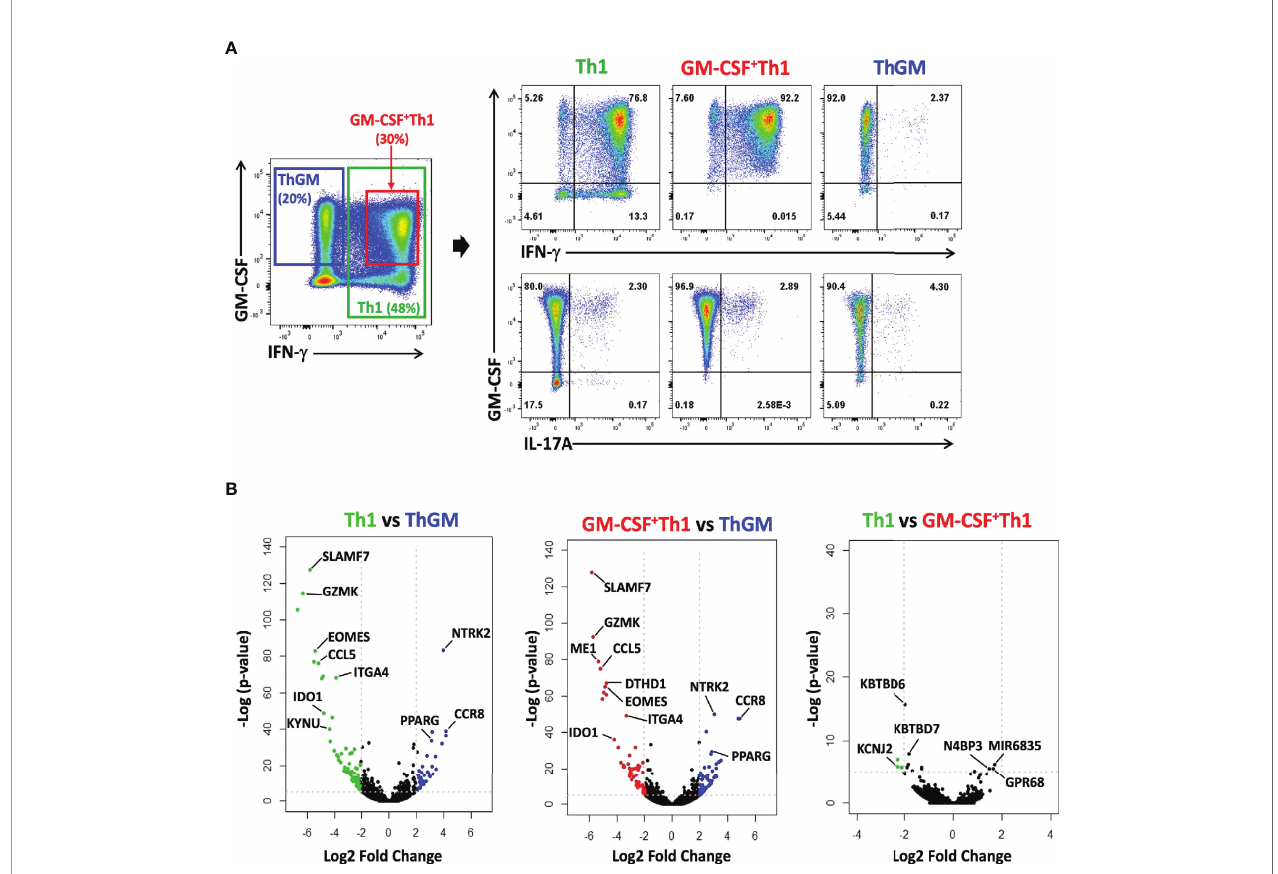
FIGURE 4 | ThGM cells have a unique transcriptome pro fi le. Human ThGM, Th1, and GM-CSF + Th1 cells were isolated from PB T M cells using a combination of FACS sorting and cytokine capture assay (n=6 subjects). RNA was extracted and analyzed using RNA-seq analysis. (A) Representative fl ow cytometry dot plots showing GM- CSF, IFN- g , IL-17A expression by total T M cells before separation, and of isolated Th1, GM-CSF + Th1, and ThGM cells isolated from PB of healthy donors. (B) Volcano plots showing 469 differentially expressed genes by Th1, GM-CSF + Th1, and ThGM cells with 218 gense being upregulated and 251 genes downregulated by ThGM cells in comparison to both Th1 and GM-CSF + Th1